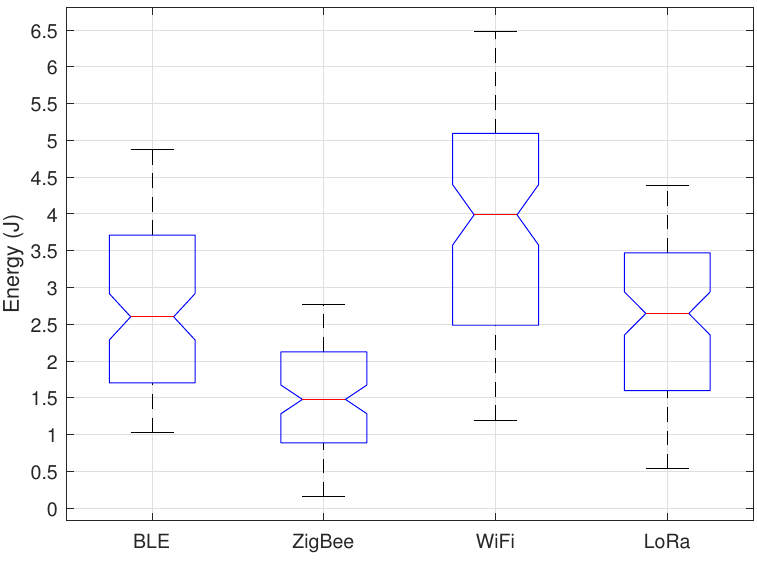
Figure 10. Energy in Joules under cooperation scheme for each technology.